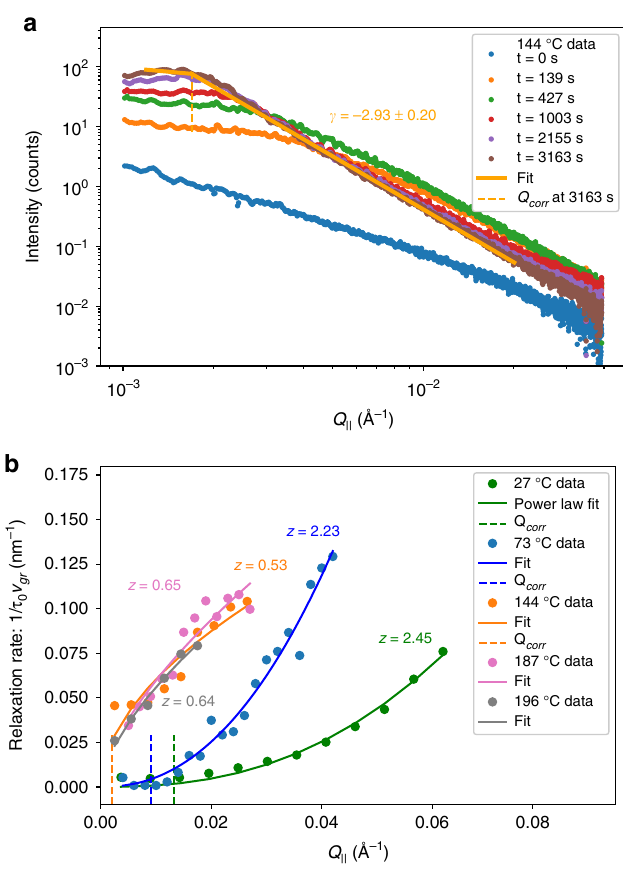
Fig. 7 Scaling analysis of correlations and intensities. a Analysis of intensity data for a C 60 thin fi lm deposited at 144 °C to extract the exponent γ . Q corr is the value of Q || where the intensity breaks away from a power law dependence. b Correlation relaxation rates at different growth temperatures derived from g (2) ( Q || , Δ t ) curves during steady-state growth. The curves are scaled by the growth velocity v gr in order to take into account differences in the deposition rates for different fi lms. The dynamic exponent z changes abruptly between the low-temperature and high- temperature